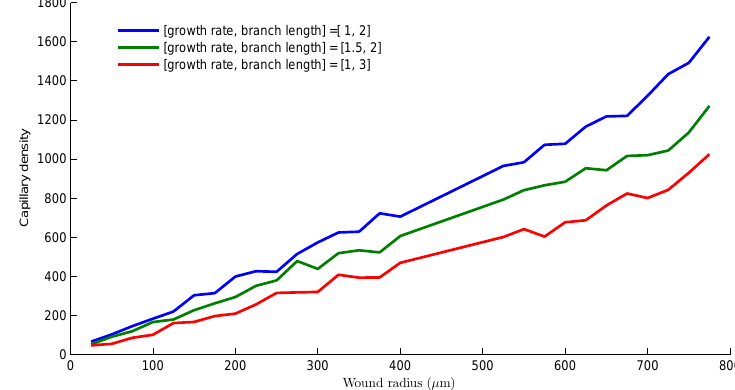
Figure 9. Comparison of capillary density from the wound edge to the wound center for 3 different growth strategies. The case [1, 2] represents capillary growth rate of 1 step and branch length of 2 steps. The case [1.5, 2] represents capillary growth rate of 1.5 steps and growth rate of 2 steps. The case [1, 3] represents capillary growth rate of 1 step and branch length of 3 steps. A step consist of 2 grid